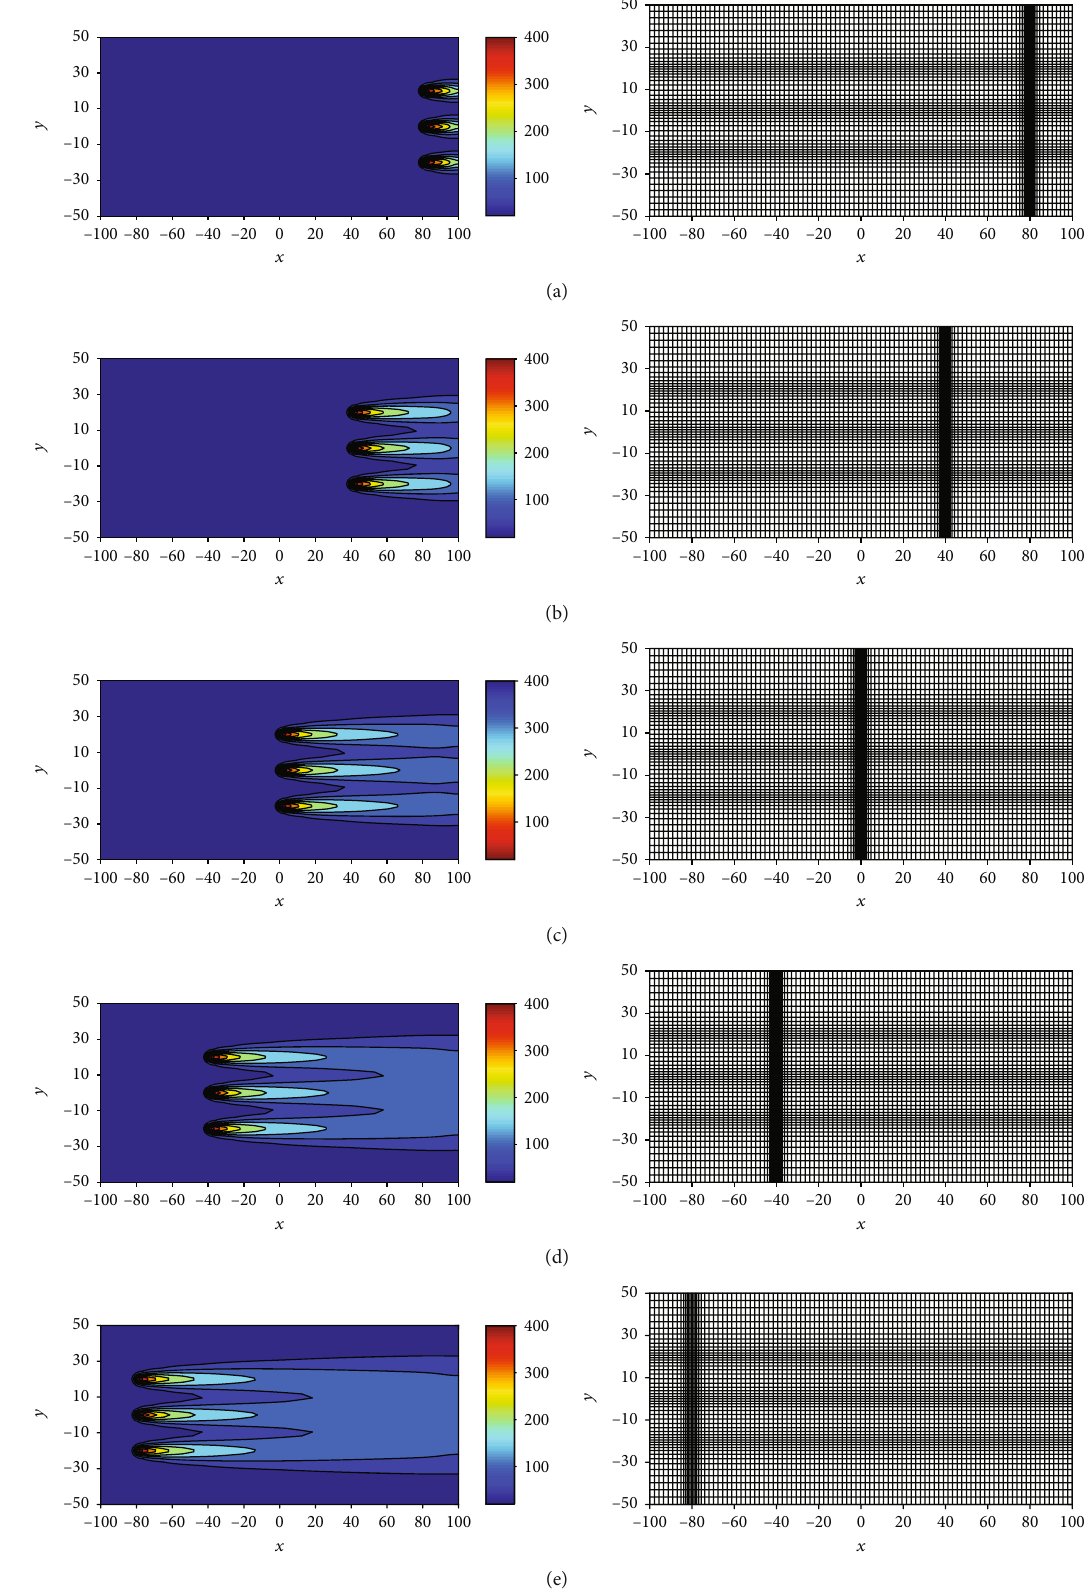
Figure 9: The transient temperature fi eld and the corresponding moving mesh at t = 1 (a), 3 , 5 , 7 , and 9 (e), respectively, for three heat sources moving along the straight lines parallel to x